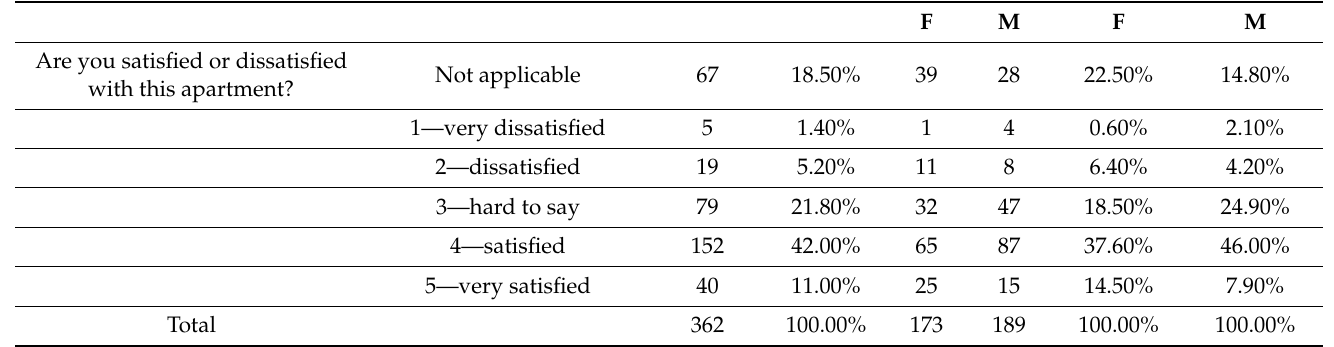
Table 6. Degree of satisfaction with the ZGM TBS premises